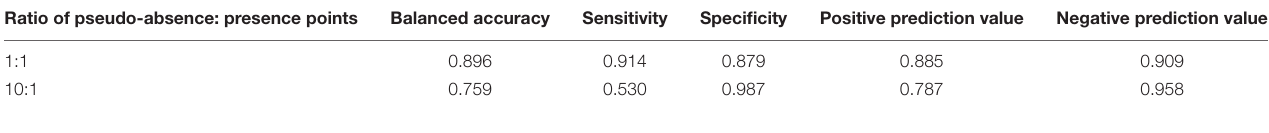
TABLE 5 | Results of confusion matrices for random forest models generated using varying ratios of pseudo-absence to presence points. Ratio of pseudo-absence: presence